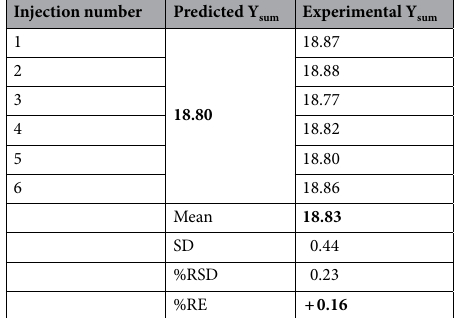
Table 6. Predicted and experimental responses at the optimum condition. Y sum summarizes the eleven resolutions, SD standard deviation, RSD relative standard deviation, RE relative error.